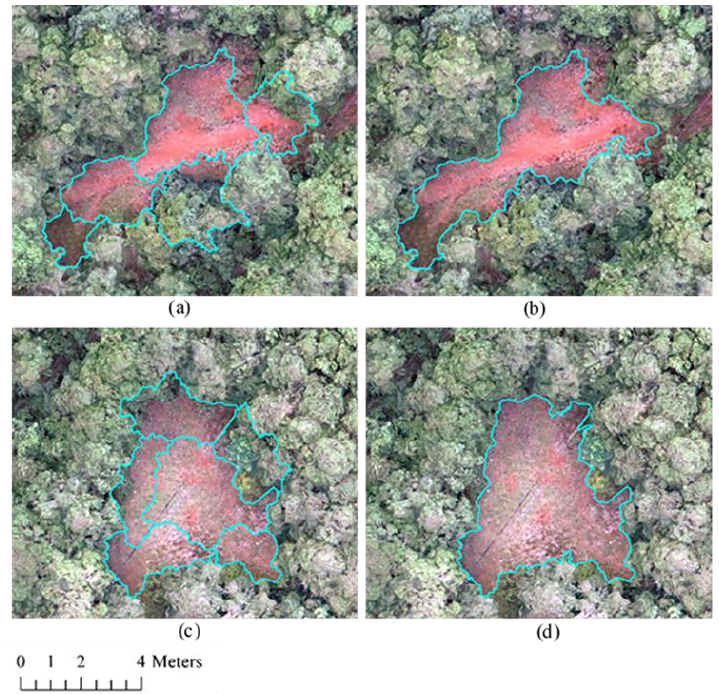
Figure 5. Segmentation subset before ( a , c ) and after ( b , d ) refinement of ill-segmented objects.